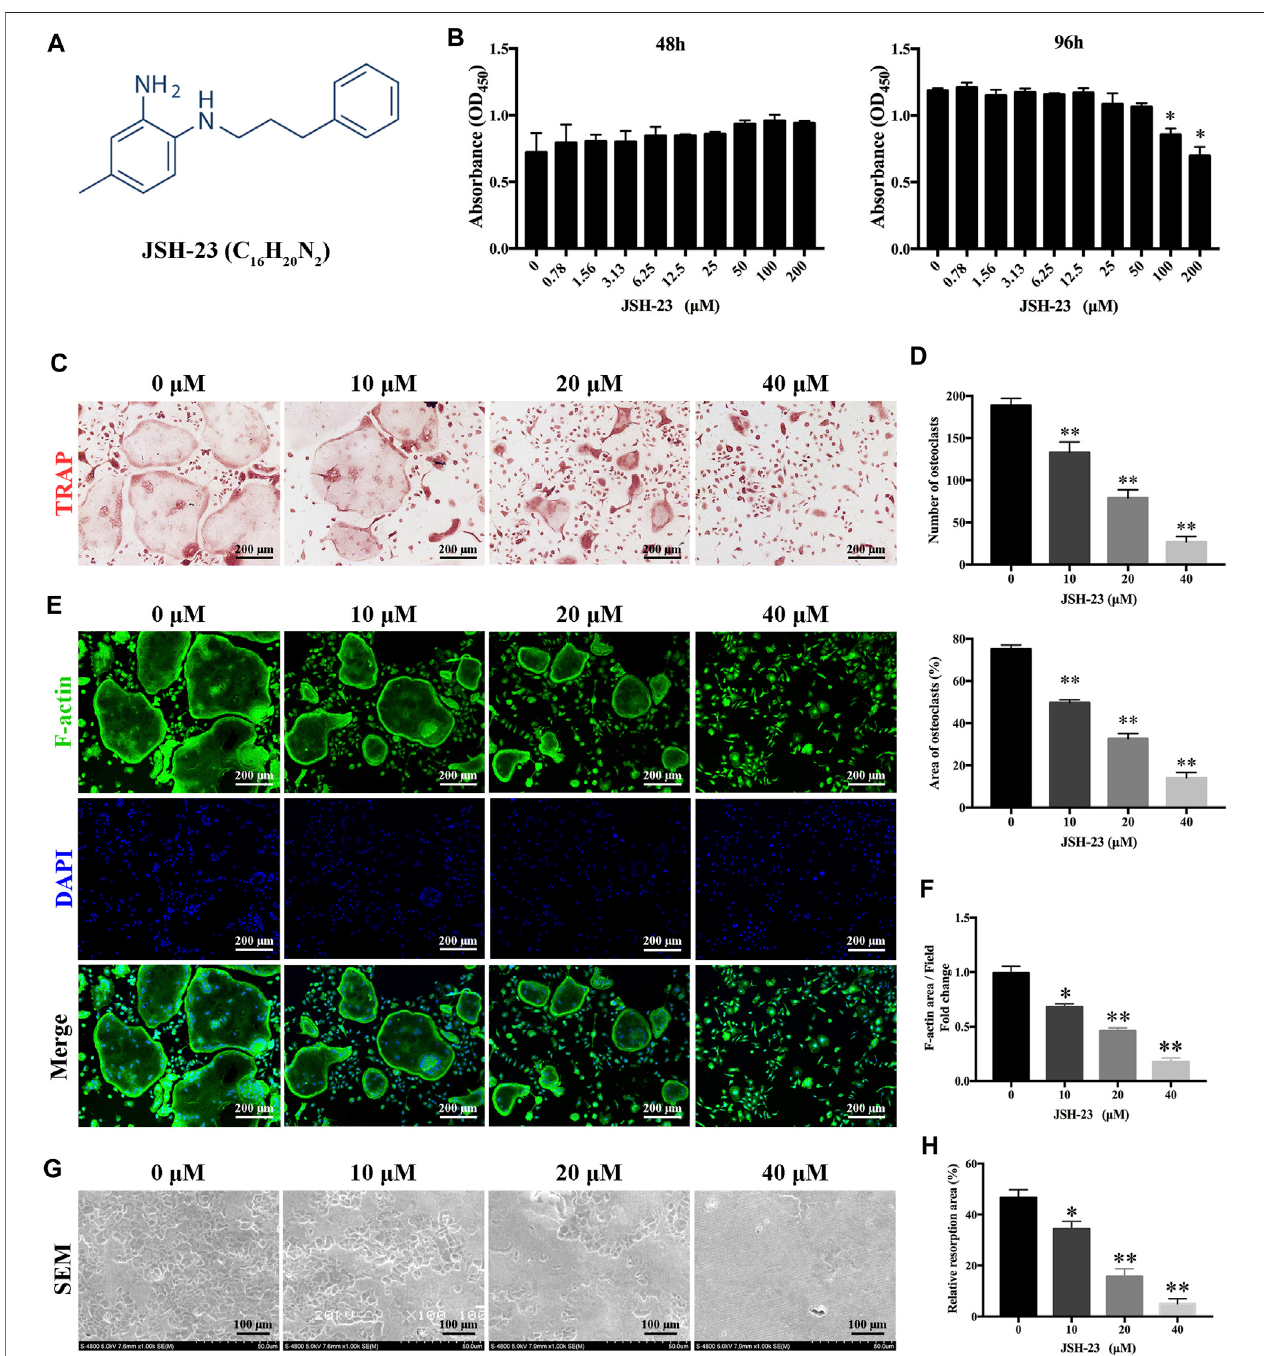
FIGURE 1 | JSH-23 suppresses RANKL-induced osteoclastogenesis and bone resorption without cytotoxicity. (A) Chemical structure of JSH-23. (B) Effects of JSH-23onBMMs viabilityasmeasured byCCK-8assay. (C) BMMs werestimulatedwithM-CSFand RANKL inthe presence ofdifferentconcentrationsofJSH-23(10, 20,and40 μ M).TRAPstainingshowedthatJSH-23inhibitedosteoclastogenesisdose-dependently. (D) Quanti fi cationofTRAP-positivecellnumbersandareaperwell. (E) Cellswere fi xedandstainedforF-actin. (F) Representative fl uorescenceimagesshowingthatrecombinantJSH-23treatmentsigni fi cantlydecreasedthesizeof F-actin ring structures. (G) Representative SEM and enlarged images of bone resorption pits. (H) The bone resorption area was measured relative to that in the control group. The values are shown as the means ± SDs, n (cid:1) 3; * p < 0.05, ** p < 0.01.